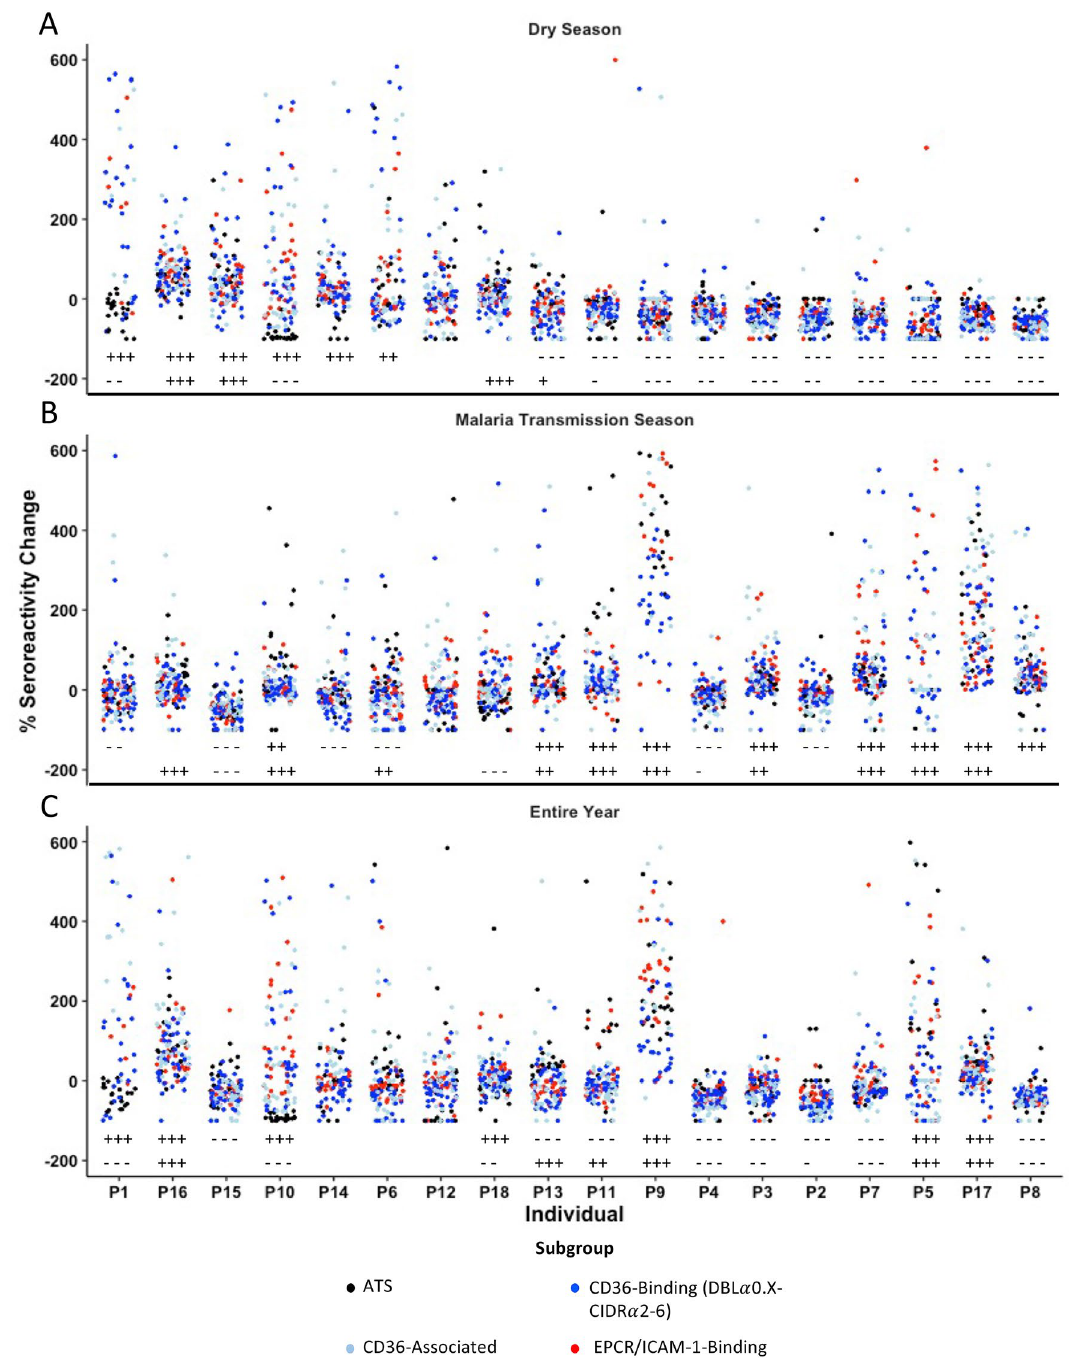
Figure 3. Percent changes in fluorescence intensity for each of the 166 Plasmodium falciparum erythrocyte membrane protein-1 (PfEMP1) fragments for each adult over the course of the dry season ( A ), malaria transmission season ( B ), and entire year ( C ). PfEMP1 fragments are separated into intracellular PfEMP1s (black) PfEMP1s (red), CD36-associated PfEMP1s (light blue), CD36-binding PfEMP1s (blue), and EPCR/ ICAM-1-binding PfEMP1s. Individuals in all three panels are organized by decreasing median percent change in fluorescence intensity across the dry season. ‘+++’ and ‘−−−’ indicate P < 0.001, ‘++’ and ‘− −’ indicate P < 0.01, and ‘+’ and ‘−’ indicate P < 0.05 in the Wilcoxon matched-pairs signed-rank test for extracellular PfEMP1s (top row) and intracellular PfEMP1s (bottom row). Values above 600% flourescence intensity change are not shown, resulting in 89.2% of all data being displayed. “CD36-associated” refers to a PfEMP1 fragment downstream from the CIDR α domain of a known CD36-Binding 3D7 PfEMP1. CIDR cysteine-rich interdomain regions, DBL Duffy binding-like, ATS acidic terminal segment, EPCR Endothelial protein C receptor, ICAM-1 Intercellular adhesion